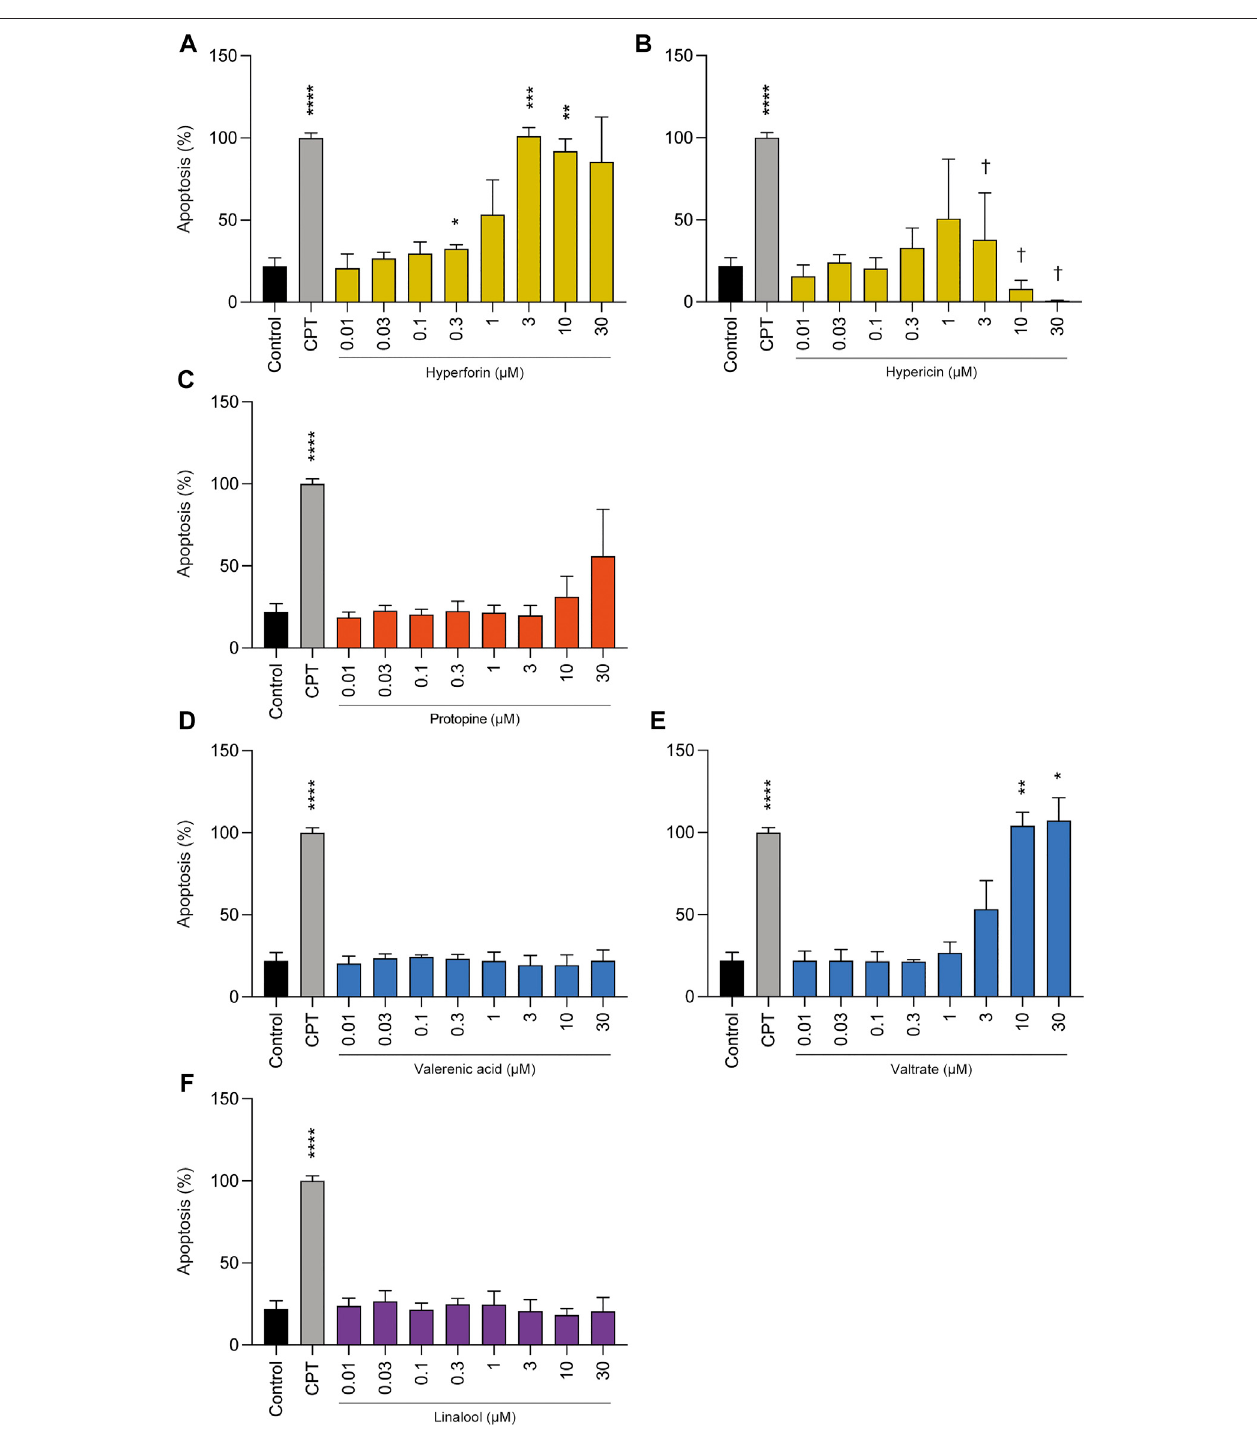
FIGURE 3 | Effects of phytochemicals on cell death of undifferentiated BeWo b30 cells after treatment for 72 h: (A) hyperforin, (B) hypericin, (C) protopine, (D) valerenic acid, (E) valtrate, and (F) linalool. Apoptosis only signi fi cantly increased for the highest concentrations of hyperforin ( ≥ 3 µM), and valtrate ( ≥ 10 µM). Hypericin showedanon-signi fi cantincreaseat1 µMfollowedbyasigni fi cantdecreaseuptothehighestconcentrationduetoanoveralldecreaseindetectedcells( † celldetection was limited due to advanced degradation). Results were normalized to camptothecin (CPT, 300 µM) = 100% ( n = 3), which was used as positive control for apoptosis.